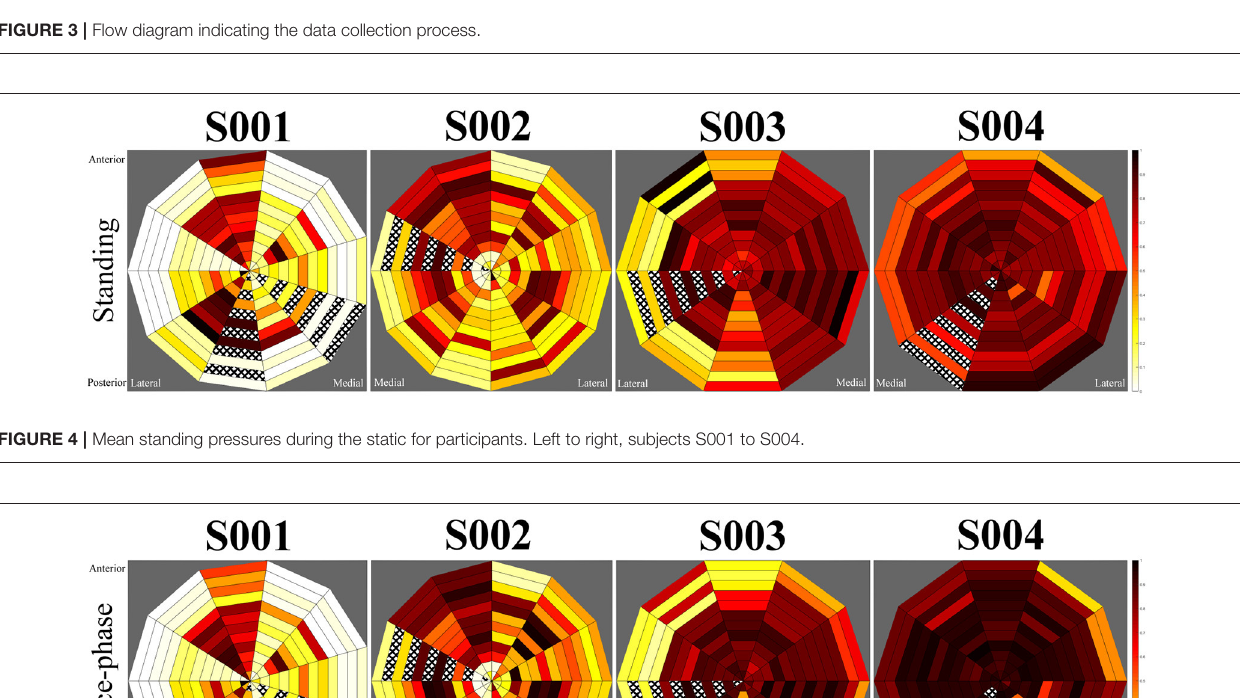
subjects depending on whether they were walking in the centre of the walkway or performing a turning motion at the walkway’s extremes. These variations were most prominent for subjects S003 and S004 (see Figure 6 ), whilst minimal differences were observed between central and turning steps for the first two subjects, suggesting the load is borne in distinct areas of the